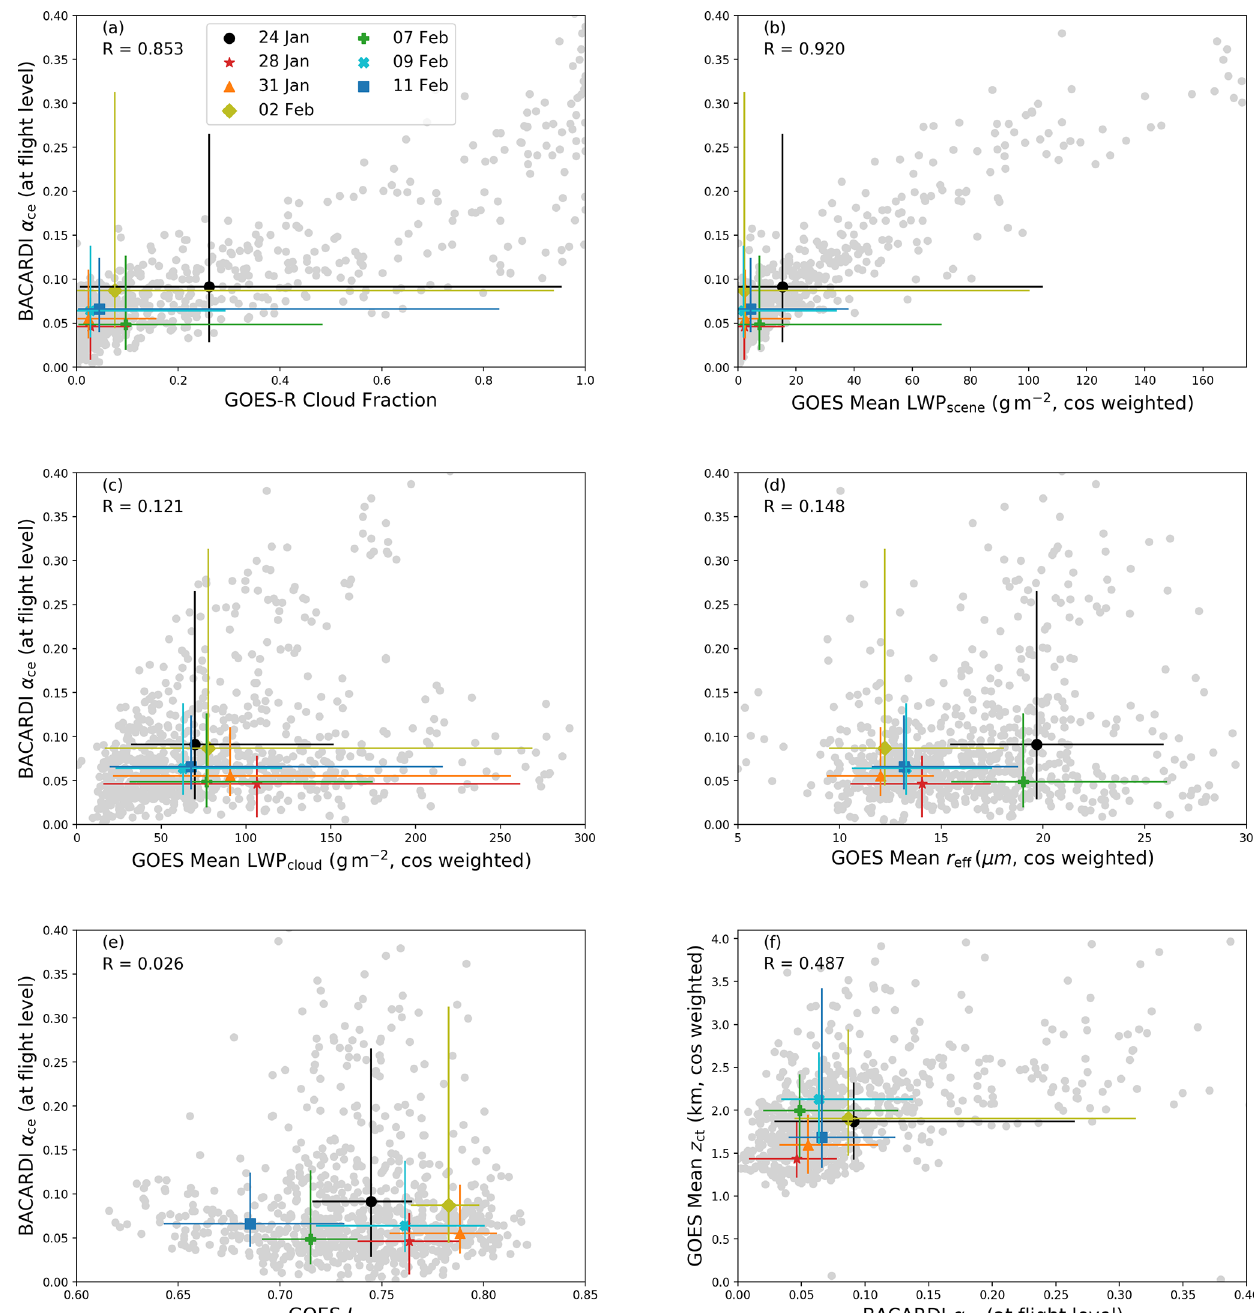
Figure 3. (a–f) Scatter plots (gray) of different cloud properties as a function of α ce for the subset of EUREC 4 A flights used in the analysis. Different colored shapes denote the median observed values from individual flights, while the associated bars indicate the range of values between the 10th and 90th percentiles. Plots are zoomed in to include at least the 10th–90th percentile ranges for each